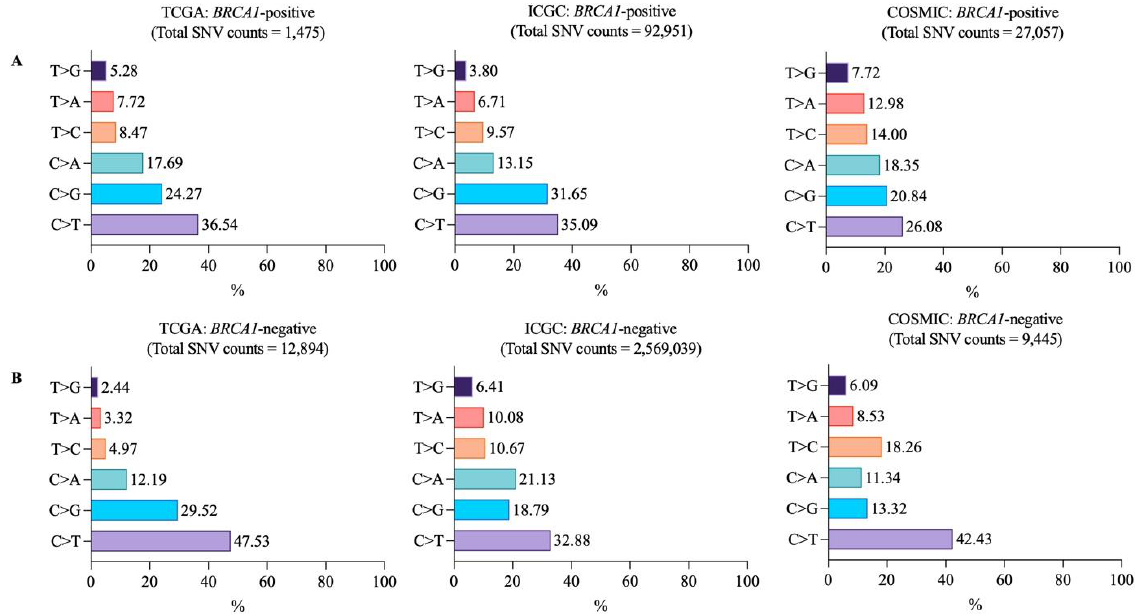
Figure 2. SNV classification of ( A ) BRCA1 -positive and ( B ) BRCA1 -negative breast cancer samples. Numbers on the bar graphs indicate the percentage of SNV per total SNV count.